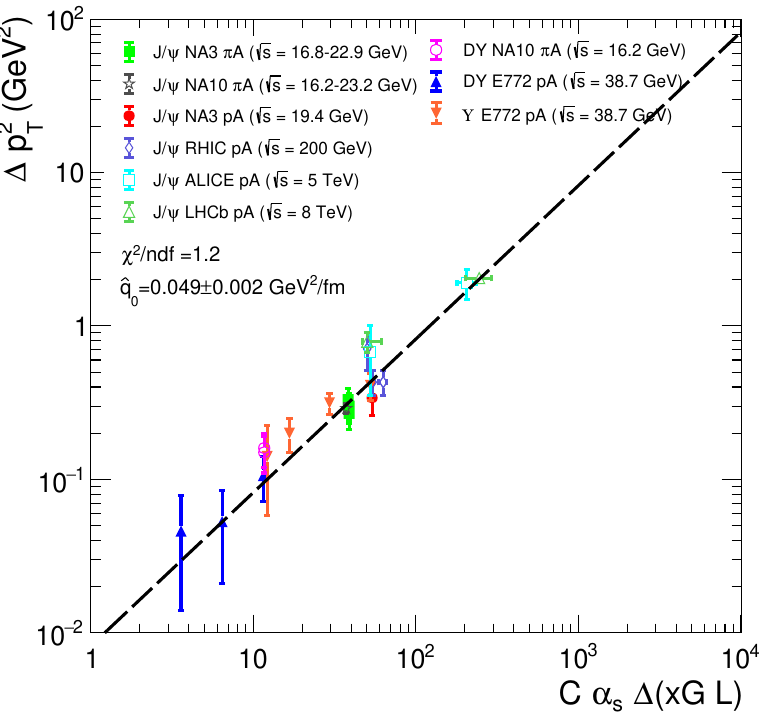
Figure 5 . Scaling of the nuclear p LO gluon